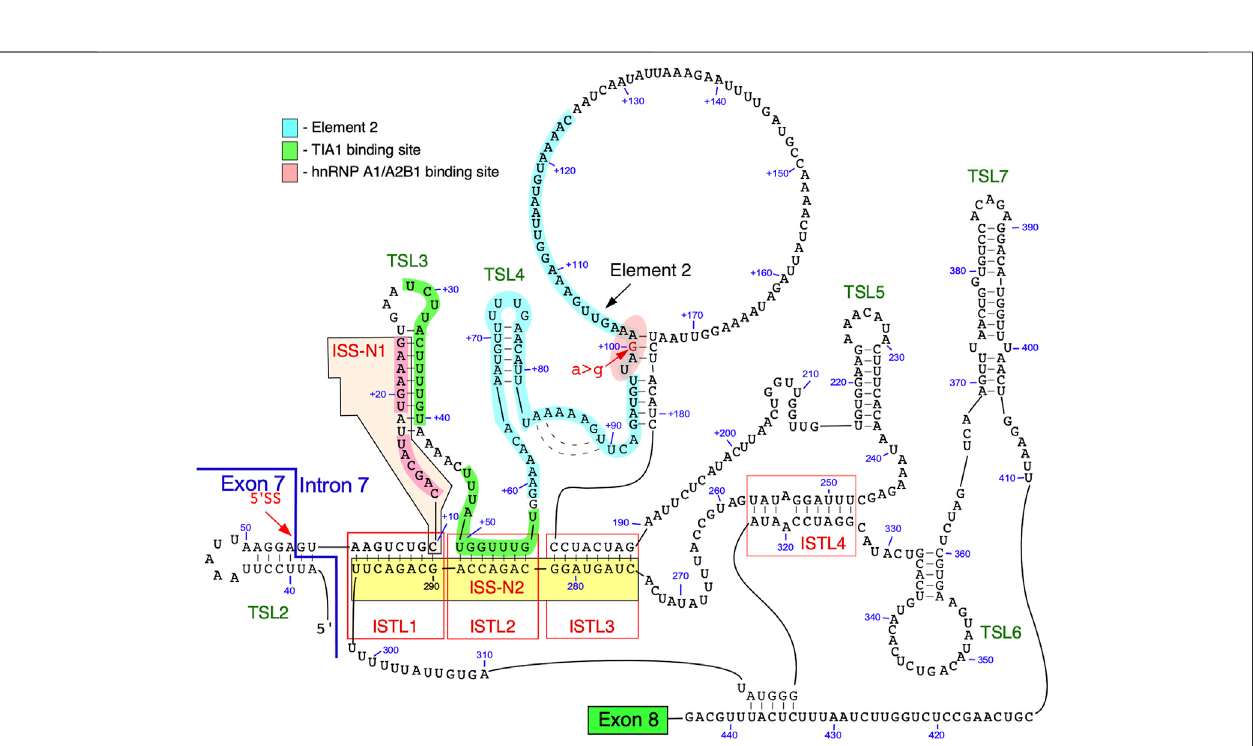
FIGURE3| Secondarystructureof SMN intron7.Thestructureisbasedoncombinedprobingbyenzymaticandchemicalmethods.Anexon7/intron7junctionas well as the 5 ′ ss are indicated. Exon 8 is represented by a green box. Numbering of nucleotides, neutral and. positive, starts from the fi rst position of exon 7 and the fi rst position of intron 7, respectively. Binding sites of hnRNP A1/A2 and TIA1 are highlighted in pink and green, respectively. Element 2 sequence is highlighted in light blue. ISTL, internal stem formed by a long-distance interaction; TSL, terminal stem-loop; ISS-N2, intronic splicing silencer 2.